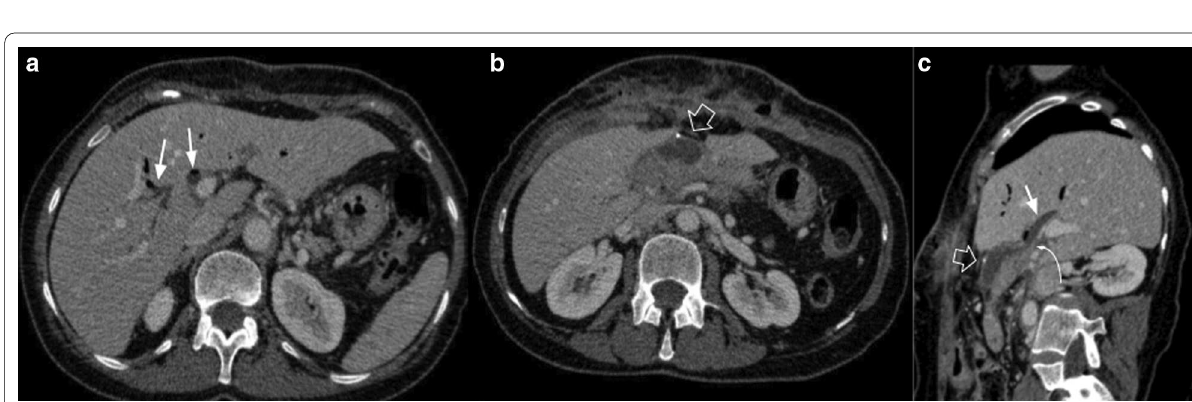
Fig. 19 Biliary fistula 67-year-old female patient with increased fluid drainage after 60 days of pancreaticoduodenectomy due to ampuloma. ( a , b , c ) Axial and oblique sagittal portal venous phase CT scan. The intrahepatic biliary duct shows dilatation and fluid level within (white arrows in a and c ). A collection in the surgical bed (empty arrow in b and c ) and biliary connection (curved arrow in c ) is also shown. Drainage analysis disclosed high bilirubin levels, which confirms the diagnosis of biliary